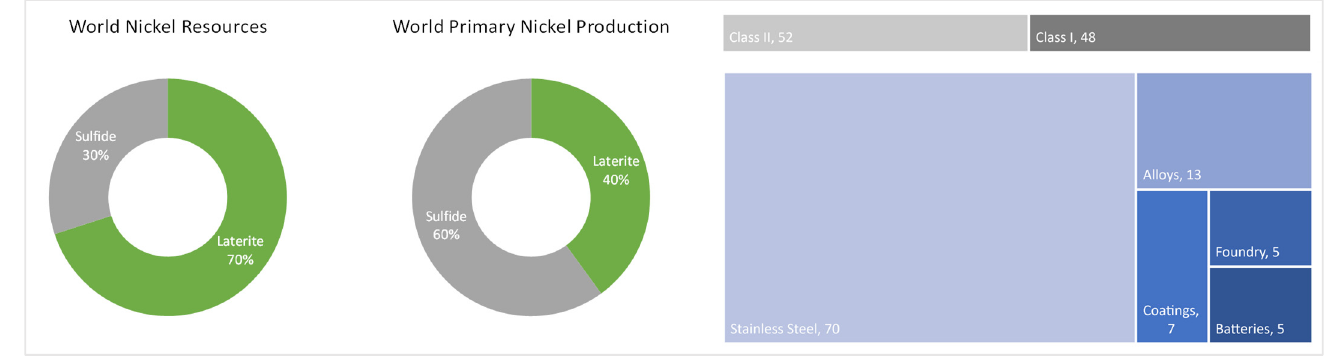
Figure 1. World nickel resources, production, and use (%).